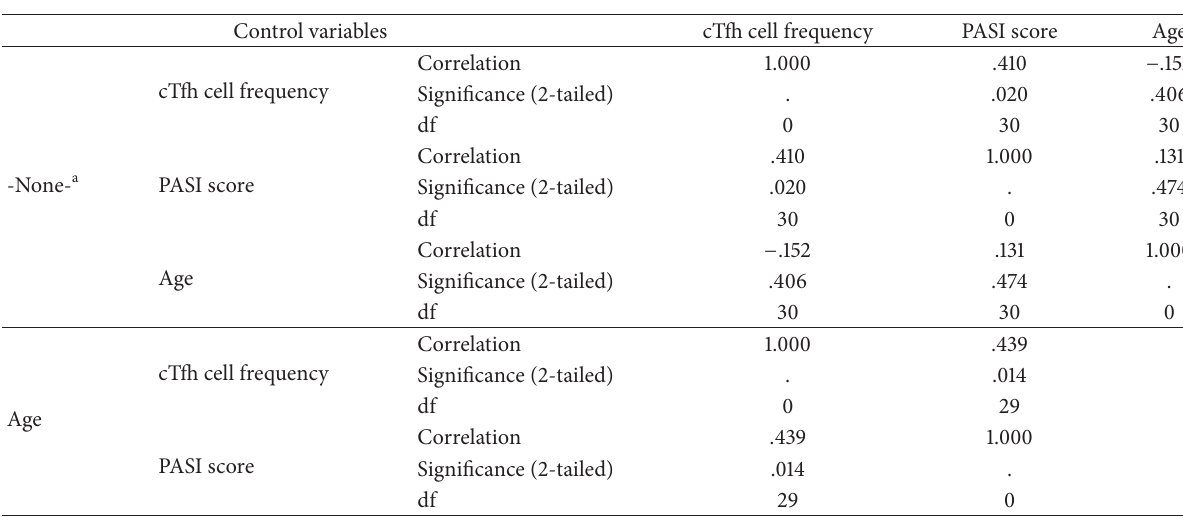
Table 2: (a) Age as the control variable. (b) Disease duration as the control